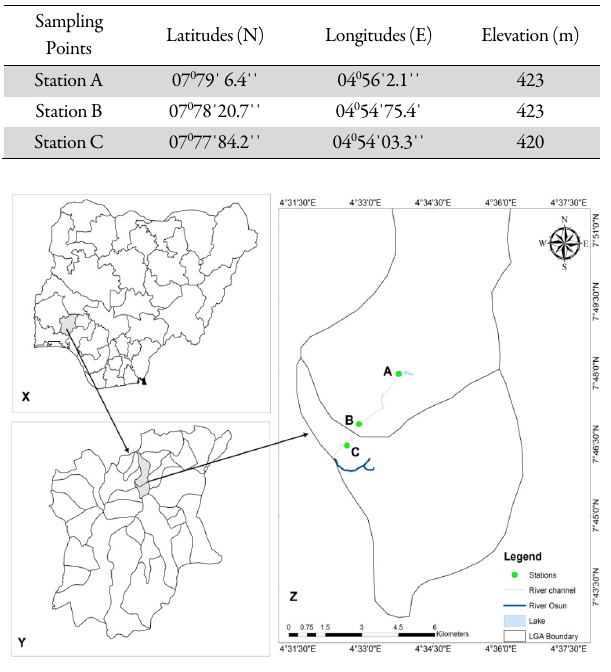
Table 1. Geographical location of the sampled stations